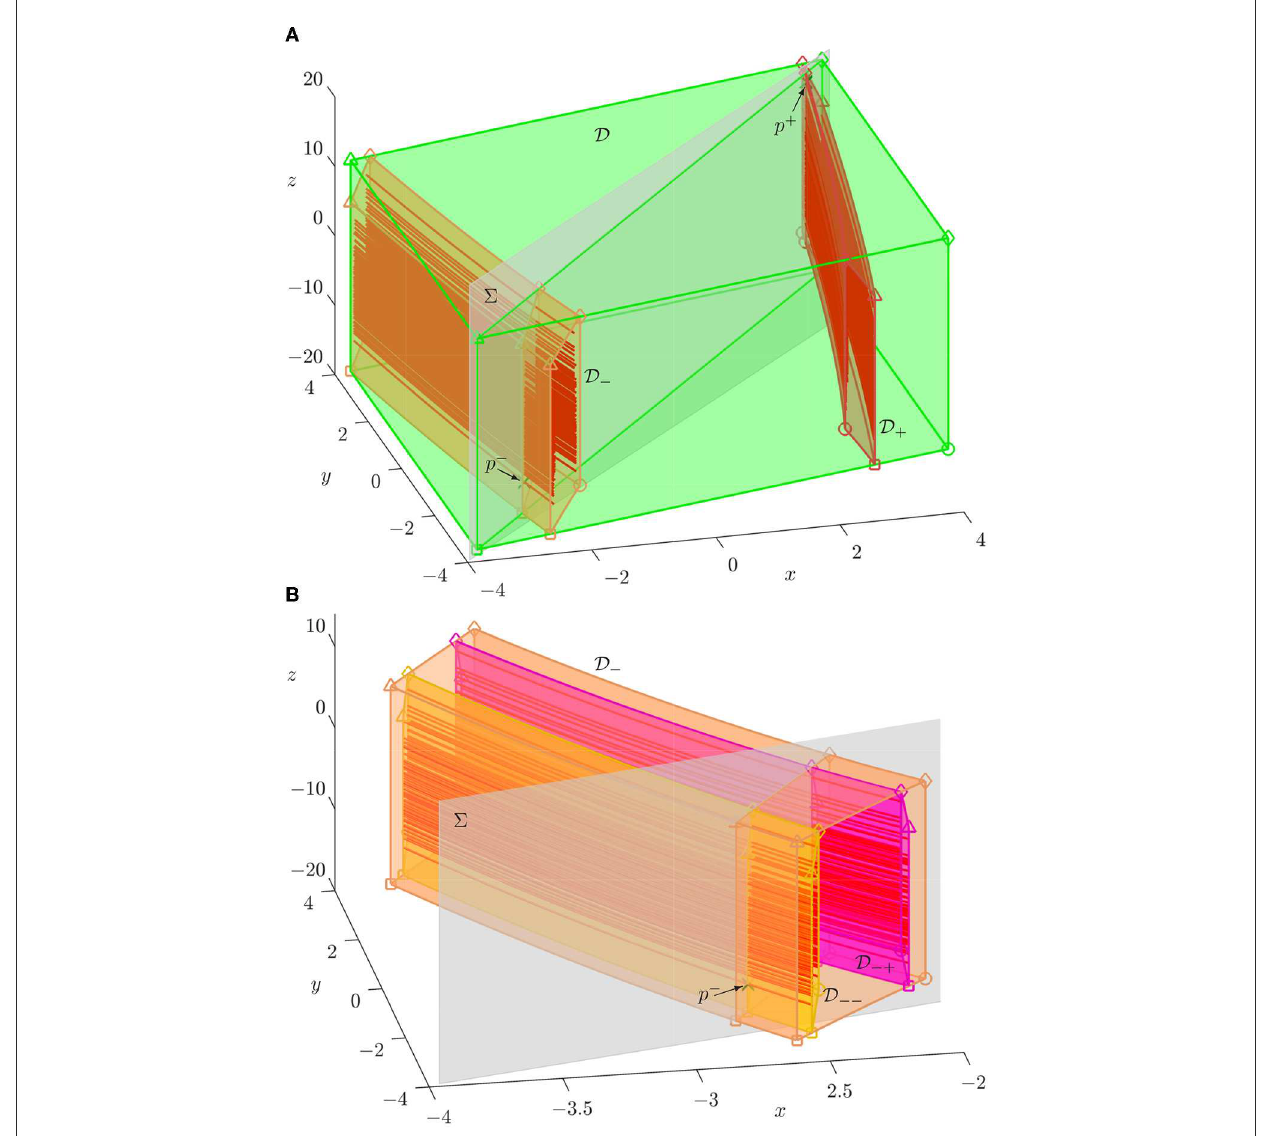
FIGURE8 First 450 segments of W u ( p ± ) ∩ D (blue curves) for ξ = 0.8, shown in (A) inside D (green), D − (orange), and D + (red), and in (B) inside D − (orange), D −− (yellow), and D −+ (magenta); also shown are p ± (green crosses) and the diagonal plane 6